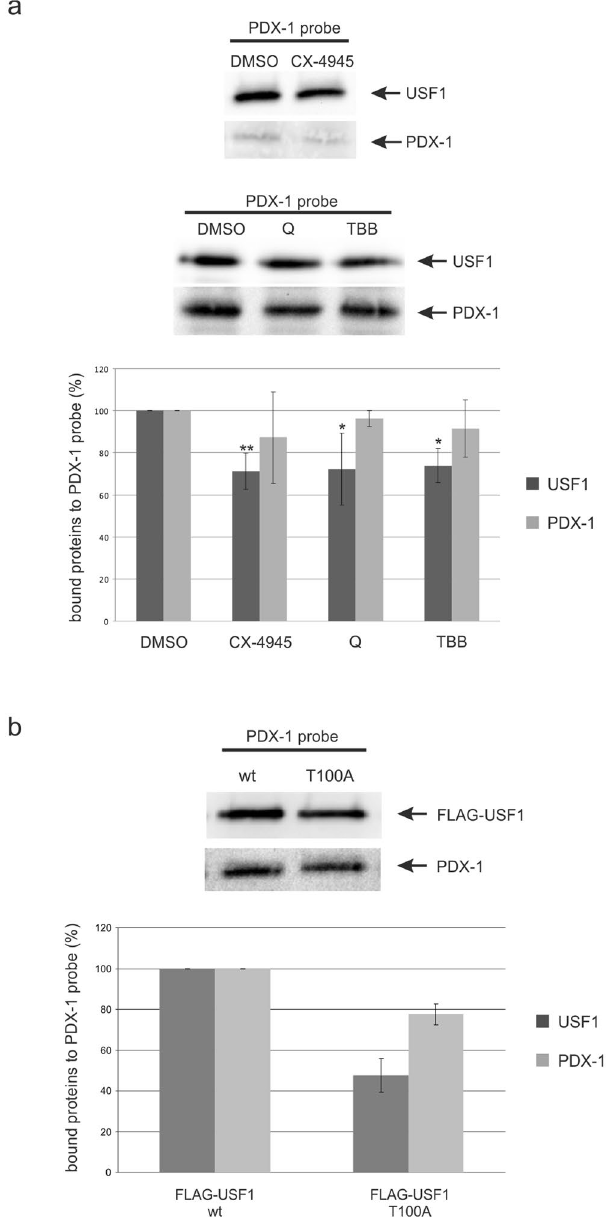
Figure 6. Pull-down assay with the PDX-1 promoter in INS-1 cells treated with CK2 inhibitors or transfected with the phospho-deficient mutant USF1 T100A . ( a ) One mg of nuclear extract from INS-1 cells treated with 10 µ M CX-4945, 50 µ M TBB or 50 µ M quinalizarin (Q) for 24 h was incubated with 1 μ g of the biotinylated PDX-1 DNA probe. The DNA-protein complex was passed through a μ Macs ™ -column and then loaded on a 10% SDS polyacrylamide gel followed by Western blot analysis. Identification of USF1-binding to the PDX-1 promoter was performed with the USF1 specific antibody sc-8983, PDX-1 was visualized with the polyclonal rabbit antiserum against recombinant full-length mouse PDX-1. Relative protein amounts of bound USF1 and PDX-1 were shown in the bar graphs. The diagram shows the mean ± SD of three independent experiments. Statistical analysis was performed by using Students t-test. * Significant difference p < 0.05, ** significant difference p < 0.01. ( b ) INS-1 cells were transfected with the wild-type USF1 or with the phospho-deficient mutant USF1 T100A for 48 hours. One mg of nuclear extract was incubated with 1 μ g of biotinylated PDX-1 DNA probe. The DNA-protein complex was passed through a μ Macs ™ -column and loaded on a 10% SDS polyacrylamide gel for Western blot analysis. Identification of FLAG-USF1-binding at the PDX-1 promoter was performed with the mouse monoclonal antibody FLAG M2 (F1804), PDX-1 was visualized with the polyclonal rabbit antiserum against recombinant full-length mouse PDX-1. Relative protein amounts of bound FLAG- USF1 and FLAG-PDX-1 was shown in the bar graphs. The diagram shows the mean ± SD of three independent experiments. Full-length blots are presented in Supplementary Figure